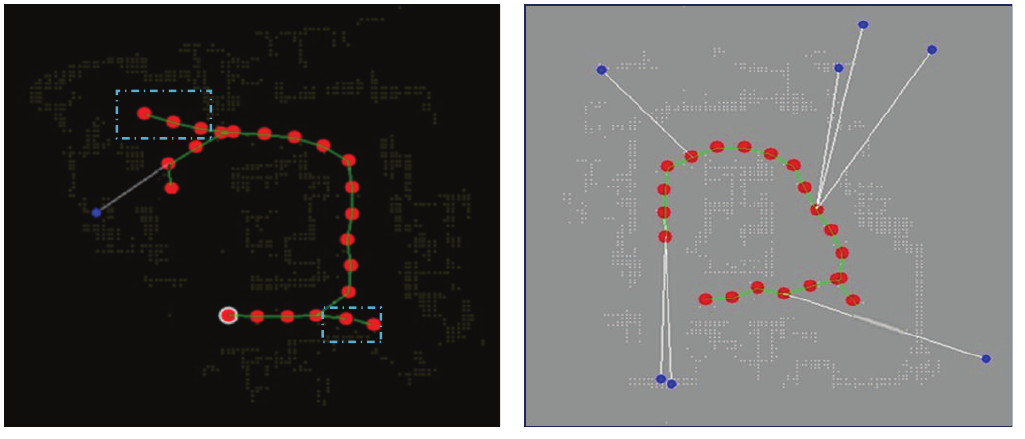
Figure 5: Comparative